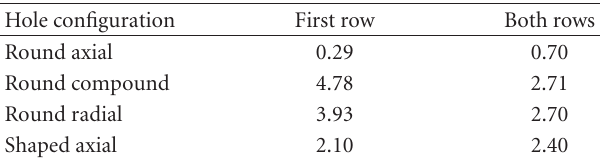
Table 3: C 1 values for (17)